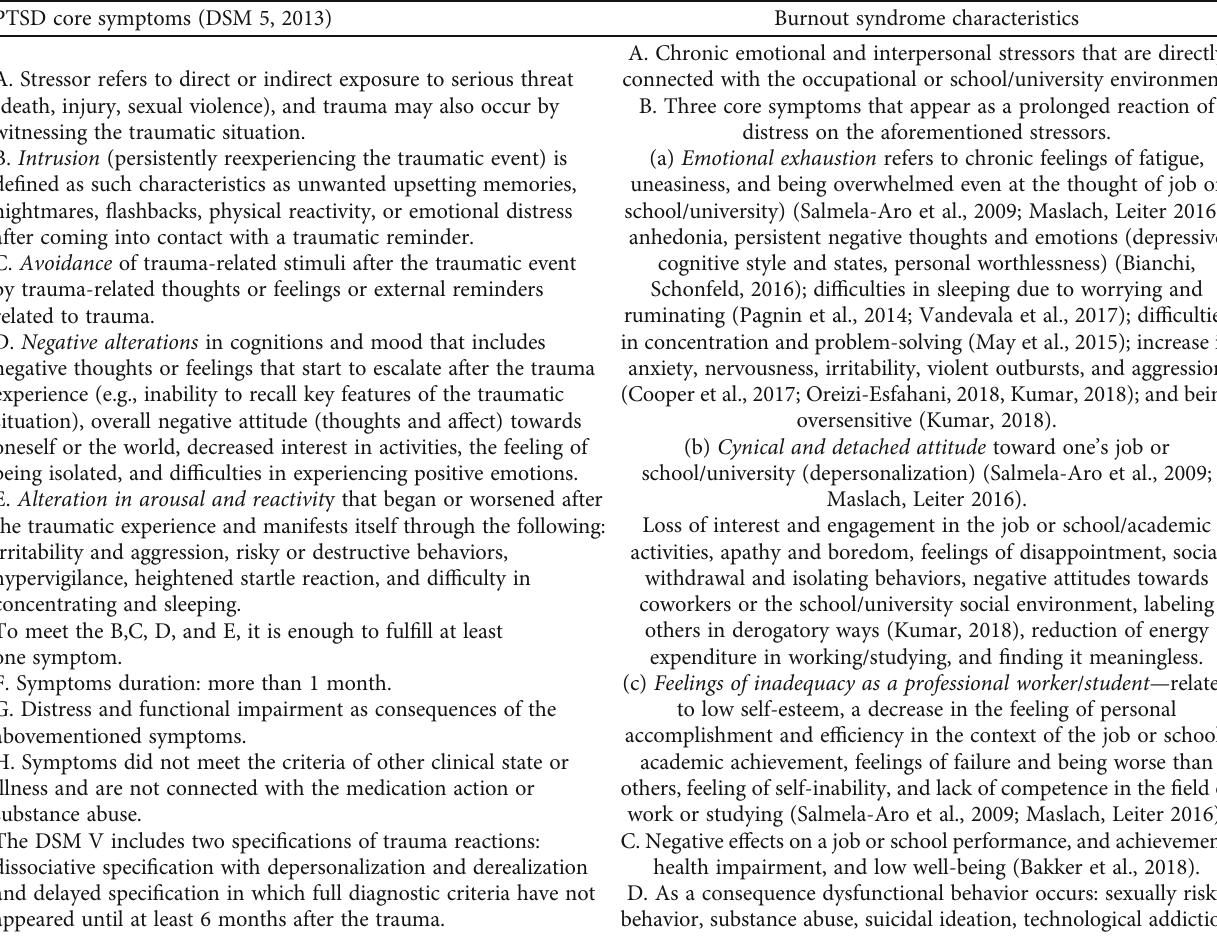
Table 1: PTSD and burnout symptoms – similarities and di ff